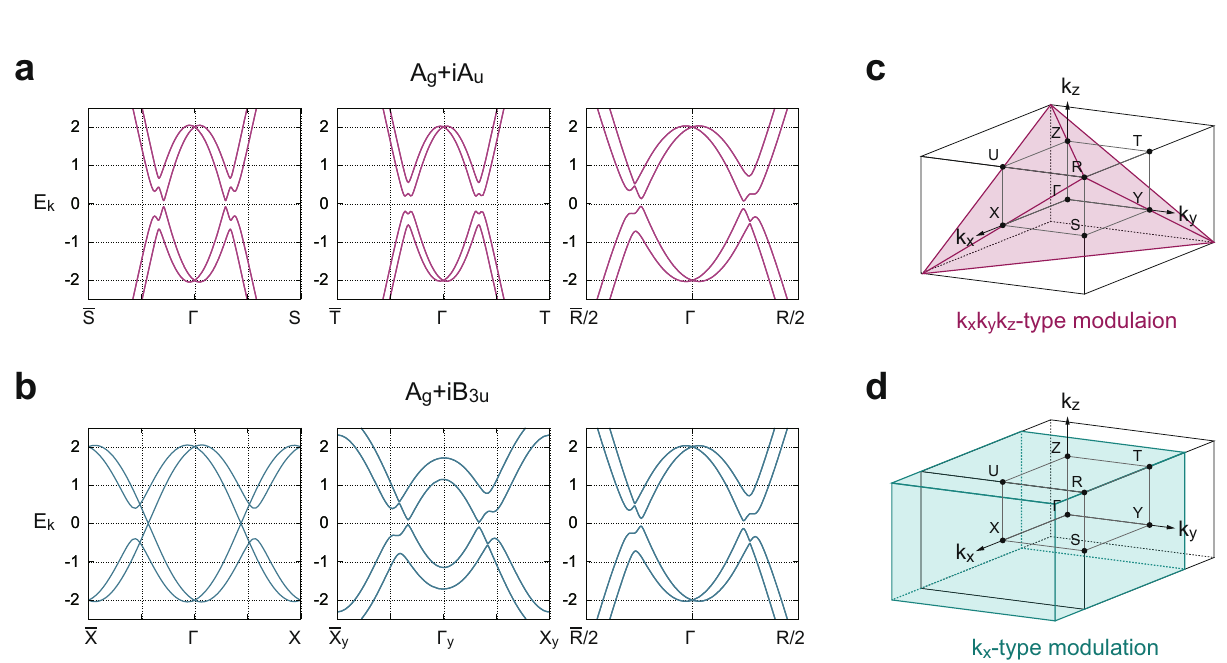
Fig. 3 Asymmetric Bogoliubov spectrum (BS) for the UTe 2 model. a , b Numerical results of BS in the UTe 2 model for the A g + iA u state and the A g + iB 3u state. c Schematic of k x k y k z -type asymmetric modulation in the Brillouin zone that is induced in the BS of A g + iA u state in a . d Schematic of k x -type asymmetric modulation that is induced in the BS of A g + iB 3u state in b . The symbols of the horizontal axis in a and b denote the k -points in the Brillouin zone of a primitive orthorhombic lattice; Γ = (0, 0, 0), X ¼ (cid:2) (cid:2) X ¼ ð π ; 0 ; 0 Þ , S ¼ (cid:2) (cid:2) S ¼ ð π ; π ; 0 Þ , T ¼ (cid:2) (cid:2) T ¼ ð 0 ; π ; π Þ , R ¼ (cid:2) (cid:2) R ¼ ð π ; π ; π Þ , Γ y = (0, π /4, 0), and X y ¼ (cid:2) (cid:2) X y ¼ ð π ; π = 4 ; 0 Þ . In the numerical calculations, parameters are set to be t ν = 1.0, μ = − 4.0, α = 0.4, and ( Δ 1 , Δ 2 ) = (0.2, 0.2 i ). The BS asymmetry appears in a and b consistent with the symmetry analysis of Tr ½ M ð 1 Þ (cid:2) ð k Þ ~ H 0 ð k Þ(cid:6) / g k (cid:4) ð d g